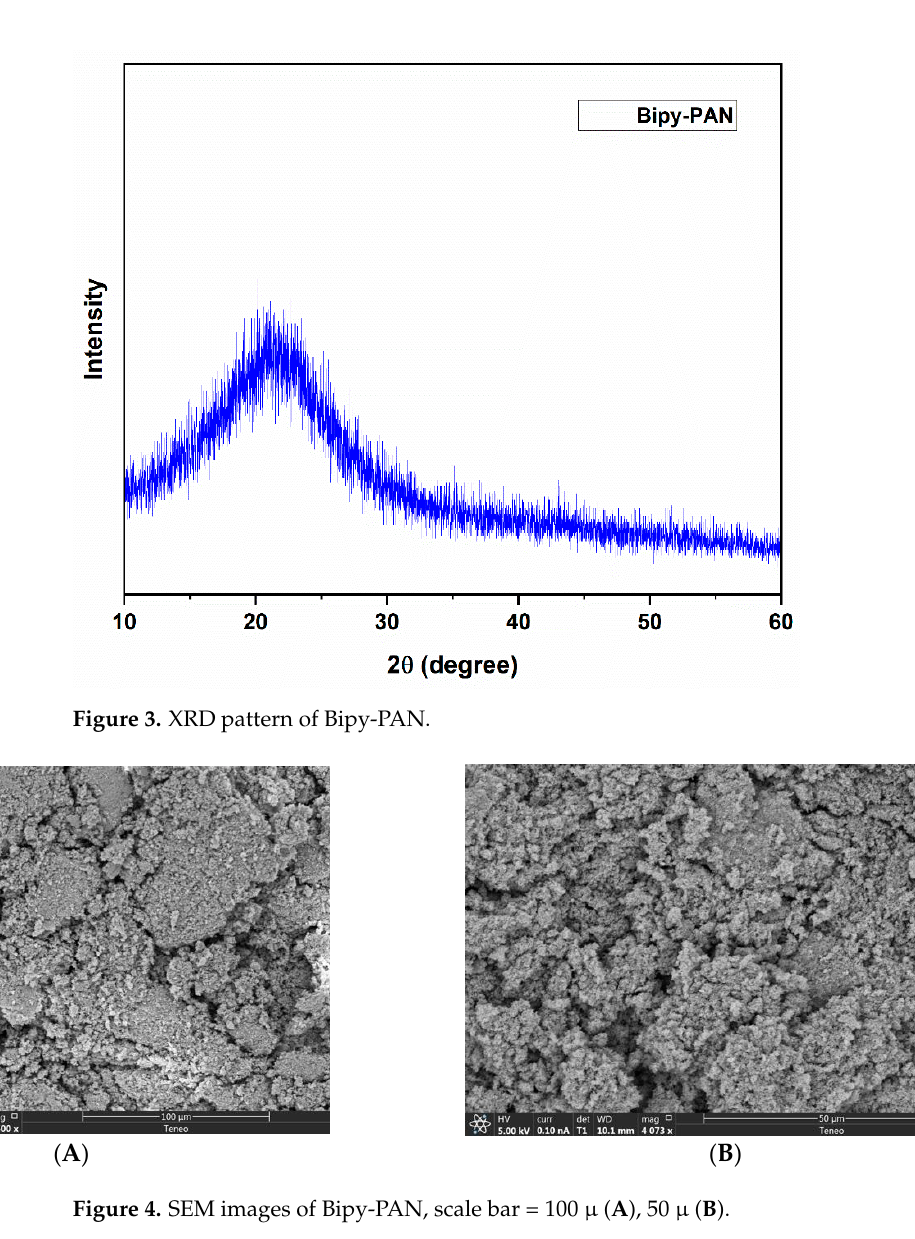
Figure 4. SEM images of Bipy-PAN, scale bar = 100 µ ( A ), 50 µ ( B ).